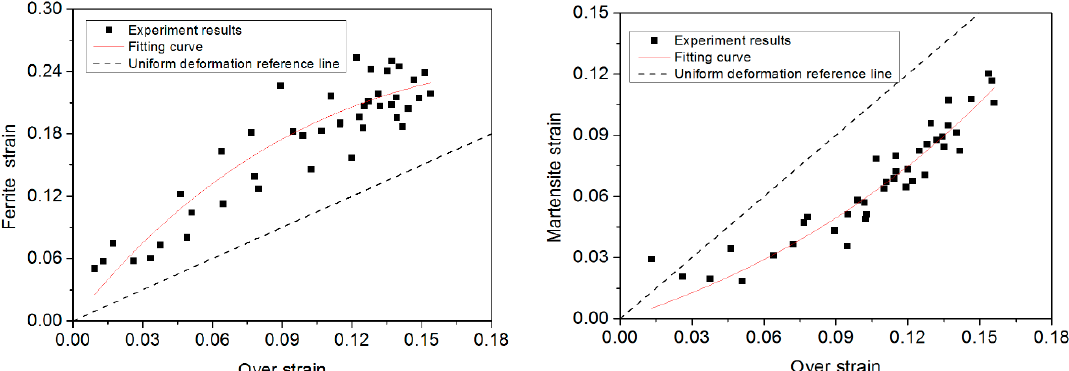
Table 2. Mechanical properties of DP800 steel.